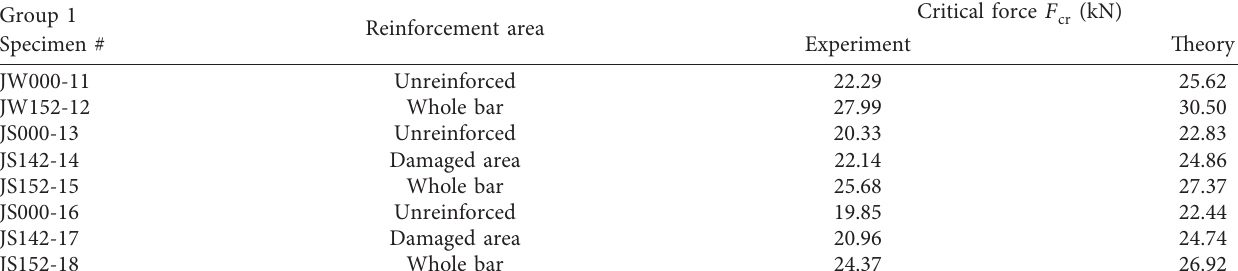
Table 6: Comparison between experimental and theoretical